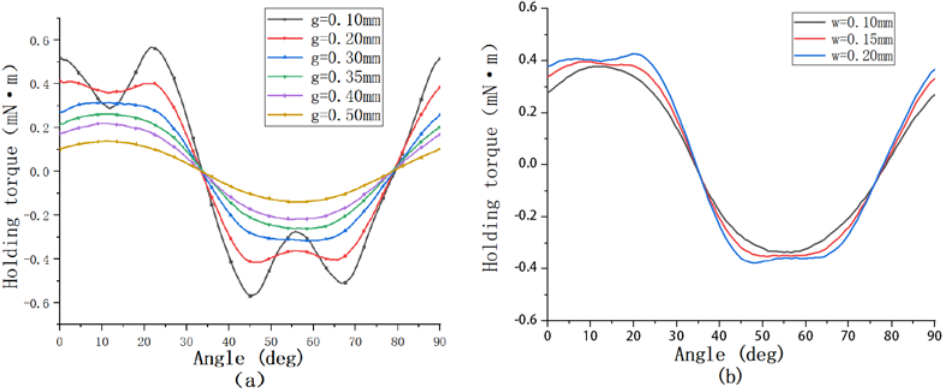
Figure 9. ( a ) Comparison of holding torque at different air gaps; ( b ) Comparison of holding torque at different gaps between claw poles.